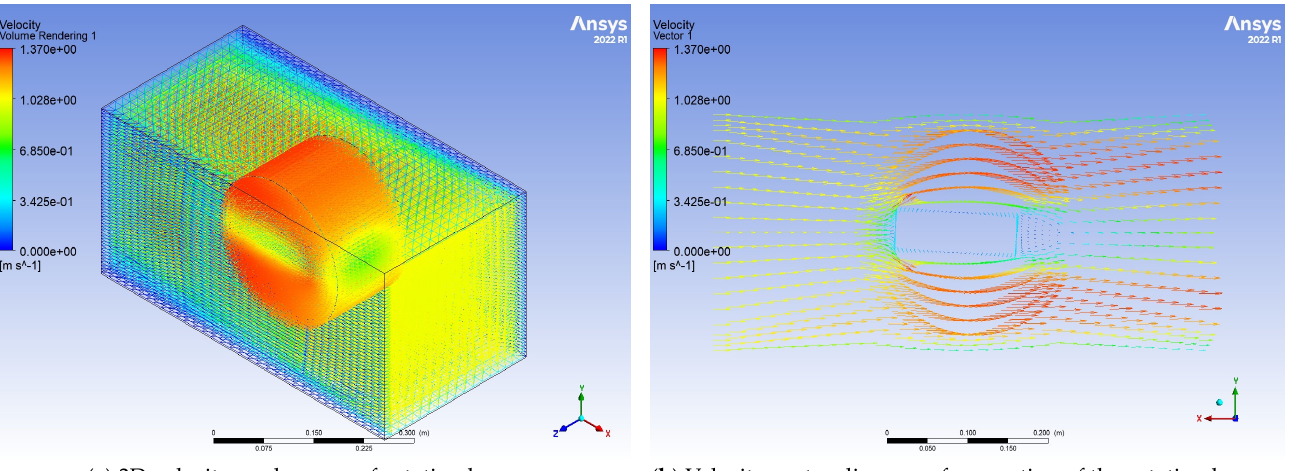
Figure 20. Three ‐ dimensional velocity nephogram of r = 2, v = 1 freezer and x ‐ y plane velocity vector diagram of freezer.